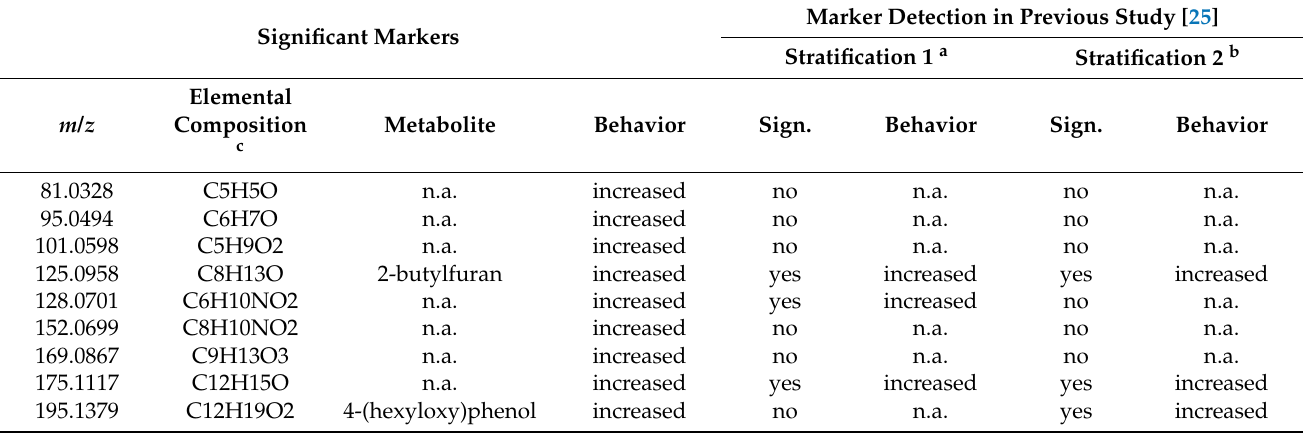
Table 2. Significant OSA-associated markers and their detection reported in the previous validation study [25].